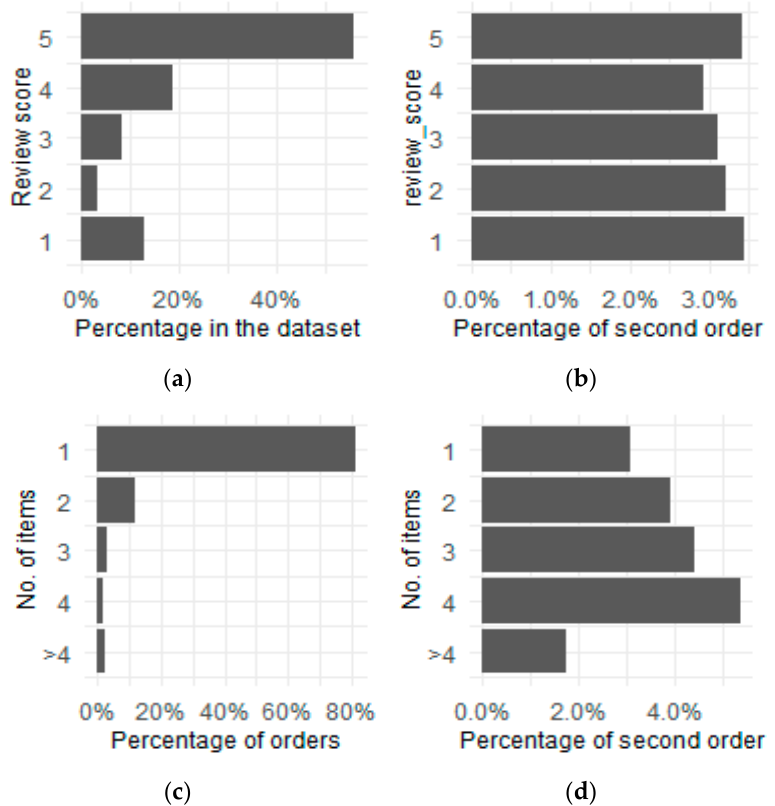
Figure 6. Percentage of orders grouped by: ( a ) review scores in general; ( b ) review scores for the